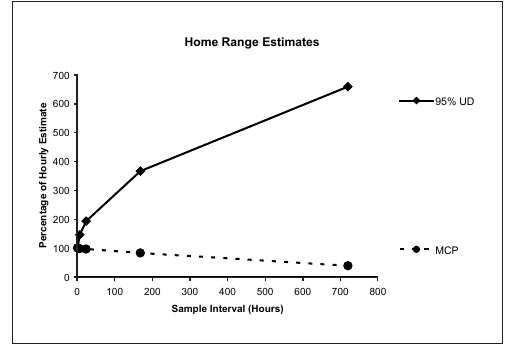
Fig. 5. Mean area of home range estimates (km 2 ) for the winter of 1998–1999, Fortymile Caribou Herd,